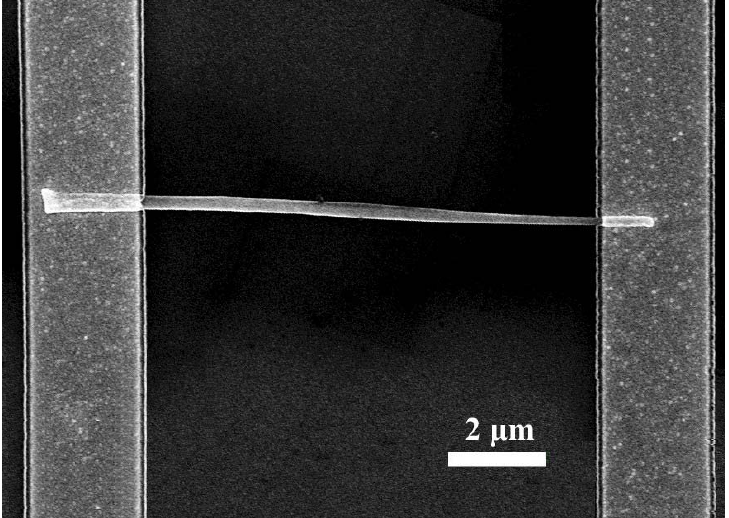
Figure 14. SEM plan view micrograph of Pt-coated ZnO single nanorod contacted at either end with Al/Ti/Au Ohmic